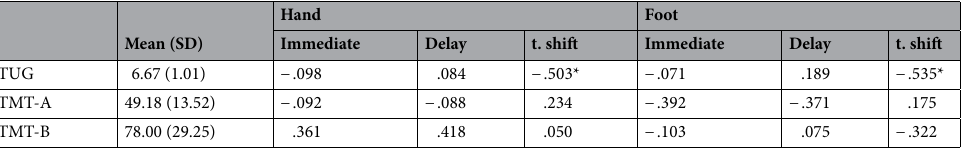
Table 2. Correlation coefficients between reaching error and TUG and between reaching error and TMT-A/B. t. shift: temporal shift in reaching error between the immediate and delay conditions. * p <